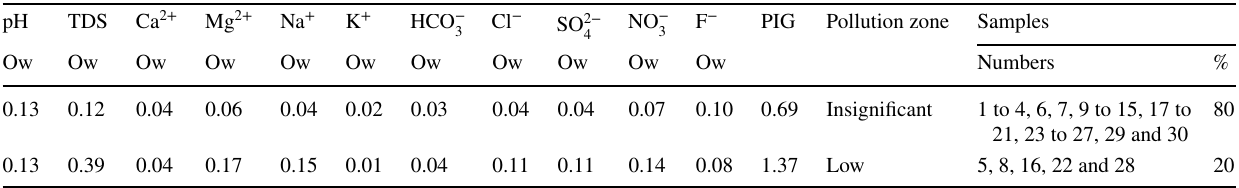
Table 4 Average values of Qw and PIG